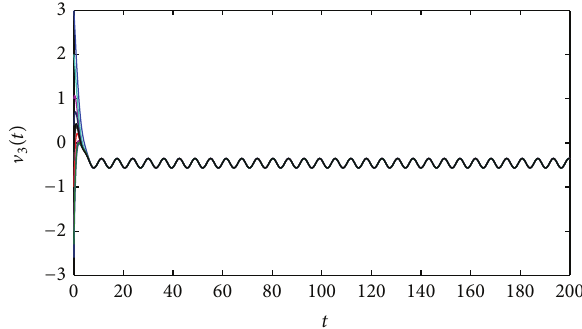
Figure 12: Transient response of state variables V 3 (𝑡) of Example